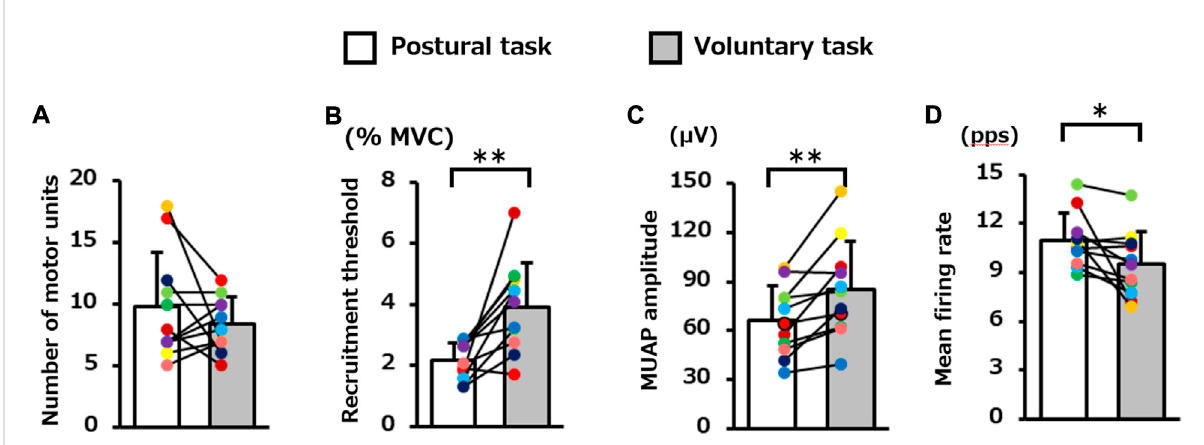
FIGURE 3 Difference in the motor unit fi ring properties between the two motor tasks. The bar graph presents; the (A) number of motor units, (B) recruitment threshold, (C) motor unit action potential (MUAP) amplitude, and (D) mean fi ring rate during the plateau phase in the postural and voluntary tasks (Paired paired t -test). Each color represents the average value obtained from each participant. ** p < 0.01, * p < 0.05.